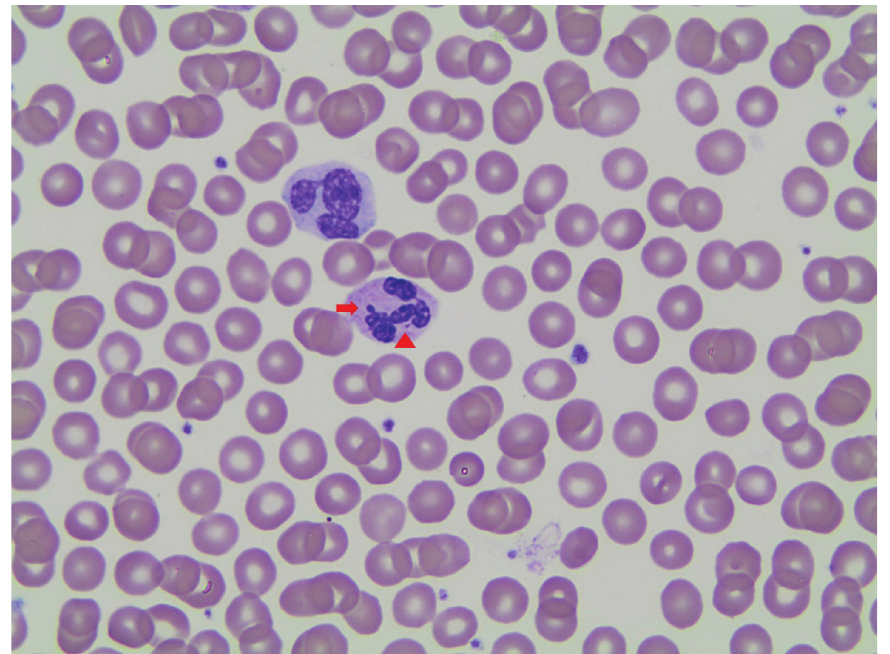
Figure 3: A neutrophil showing one Barr body (arrow) and one “barbed-wire” type aberrant nuclear projection (arrow head) (Wright Giemsa stain, 100x